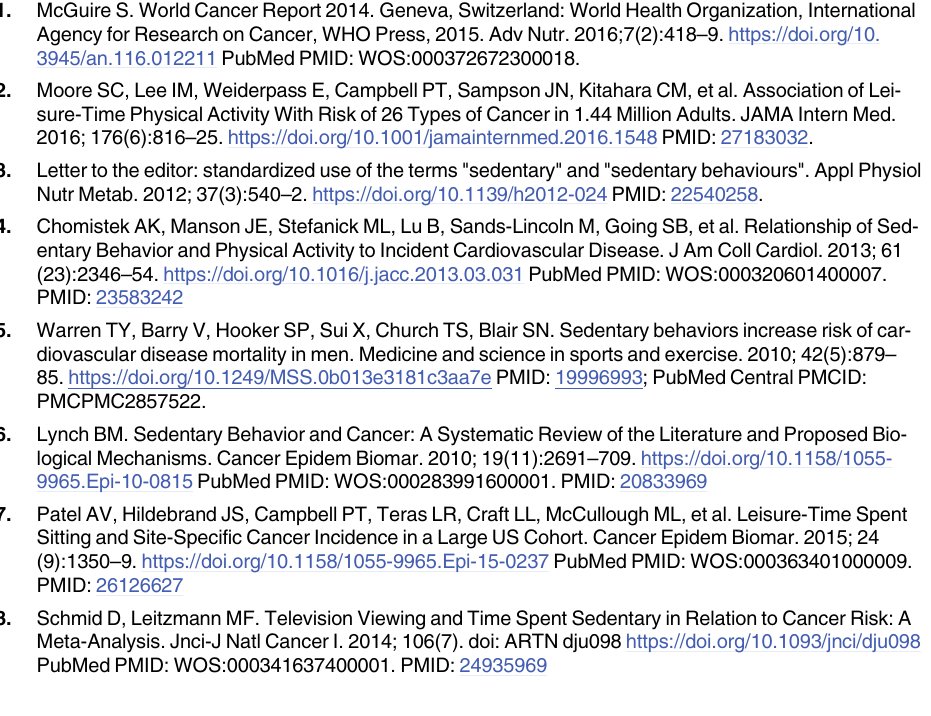
S1 Table. Joint associations of sitting and PA with total cancer—crude estimates in men. S2 Table. Joint associations of sitting and PA with colorectal cancer–adjusted estimates in